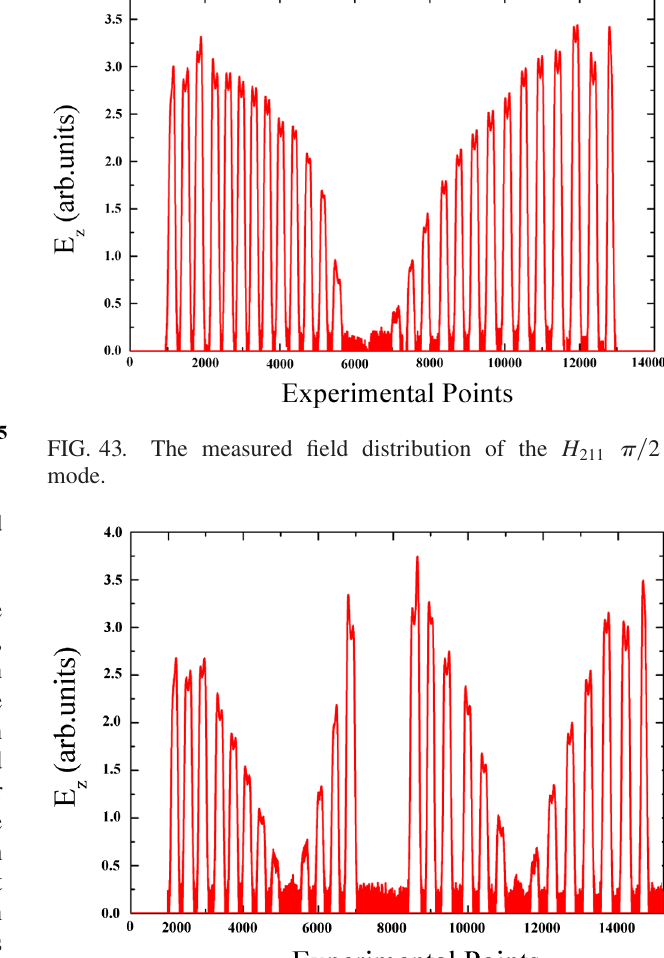
FIG. 44. The measured field distribution of the H